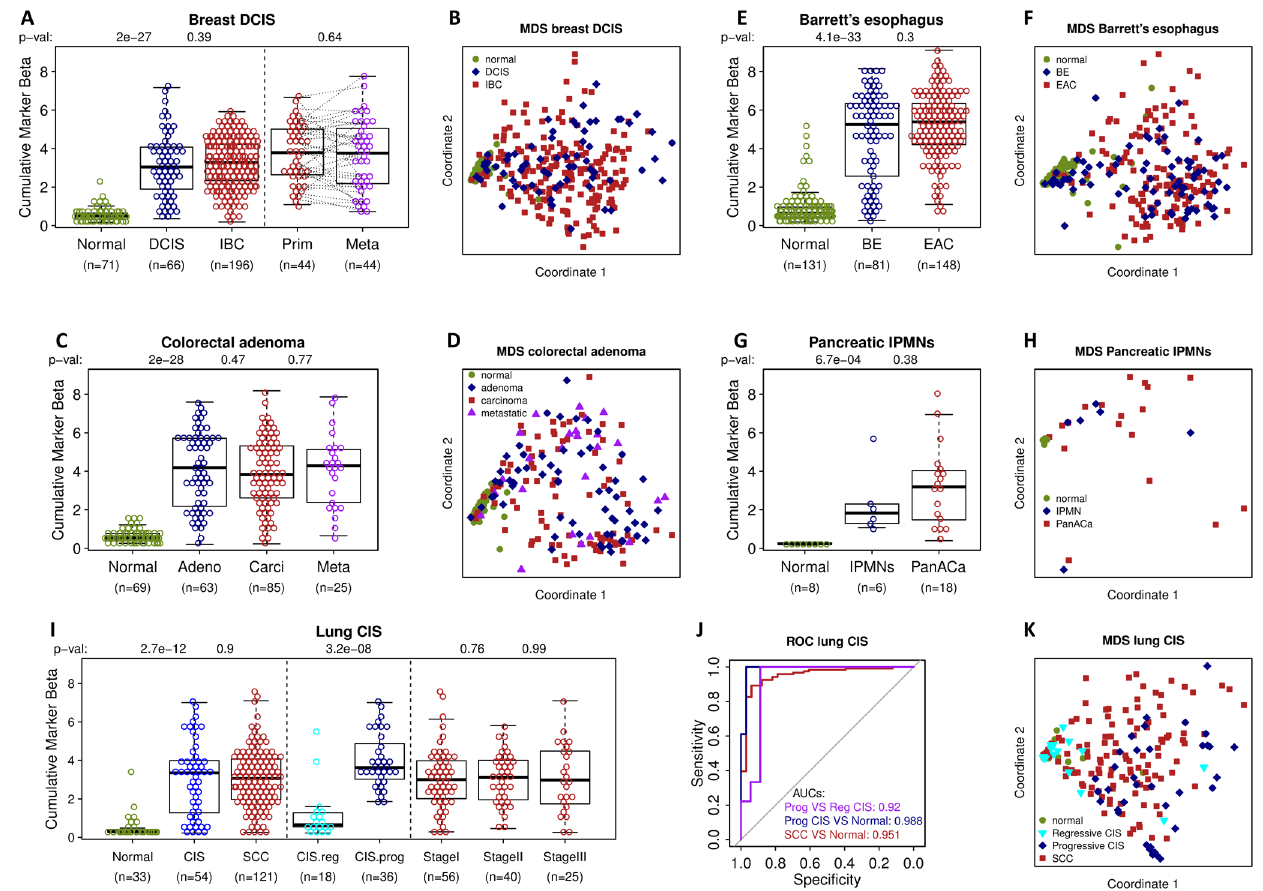
Figure 1. DNA methylation of the biomarker loci occurs early in carcinogenesis. The figure shows data from five primary carcinoma sites: breast ( A , B ), colorectal ( C , D ), esophagus ( E , F ), pancreas ( G , H ) and lung ( I , J , K ). Boxplots ( A , C , E , G , I ) show cumulative DNA methylation of the 10 biomarker loci in normal tissue samples, precancerous lesions, and tumor samples. The y-axes of plots represent the sums of beta values of the entire set of 10 biomarker CpG Illumina probes. The p-values (Wilcoxon rank-sum test) depicted at the top indicate significance of differences between neighboring groups of samples. The breast boxplots ( A ) in addition show DNA methylation of the biomarker set in 44 pairs of primary breast tumors and lymph node metastases. The lung boxplots ( I ) in addition present the precancerous lesion (carcinoma in situ (CIS)) cohort split into progressive and regressive sub cohorts and lung tumor (squamous cell carcinoma (SCC)) cohort split into stages I-III. The multidimensional scaling (MDS) plots ( B , D , F , H , K ) show multidimensional scaling of pairwise distances derived from beta values of 10 biomarker CpG probes of the same sample cohorts as in the boxplots. The receiver operating characteristic (ROC) plot ( J ) shows that the cumulative DNA methylation of the 10 biomarkers can differentiate progressive lung CIS samples not only from normal lung tissue samples (blue curve), but also from regressive lung CIS samples (purple curve). DCIS, ductal CIS; IPMN, intraductal papillary mucinous